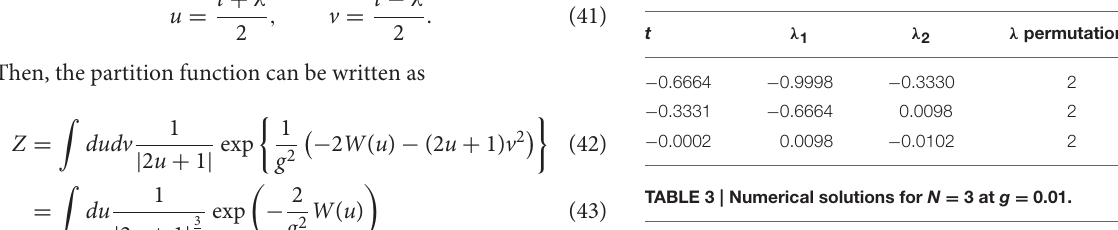
TABLE 2 | Numerical solutions for N = 2 at g = 0.01.